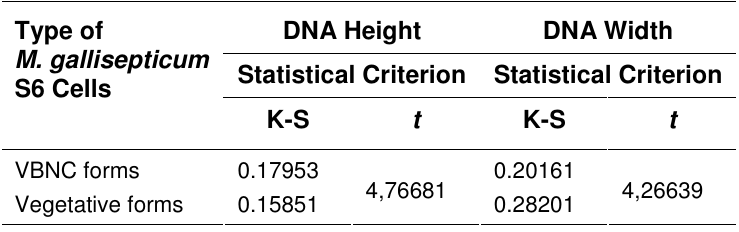
Values of Kolmogorov-Smirnov (K-S) Test for Goodness of Fit to Normal Distribution and Student’s t Test for DNA Parameters DNA Height DNA